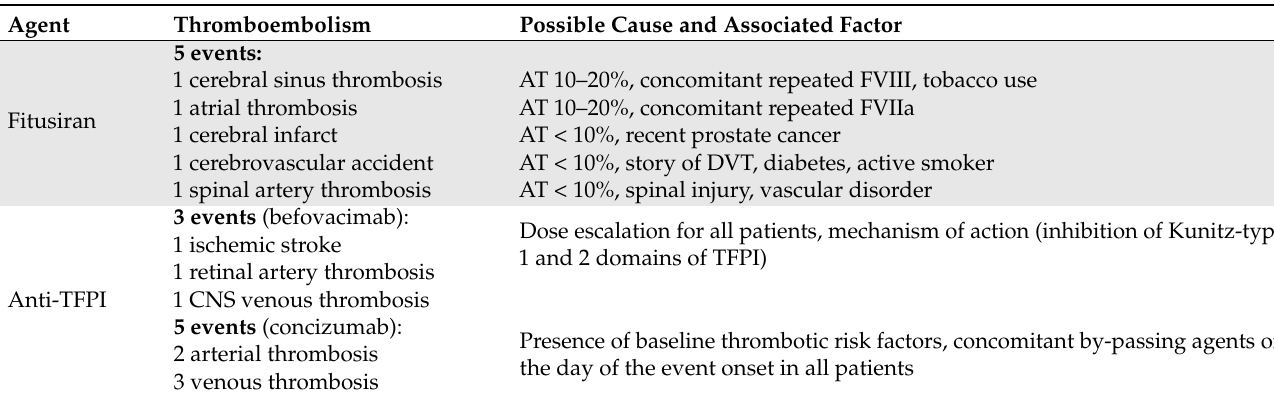
Table 1. Thrombotic events reported during clinical trials with novel non-replacement